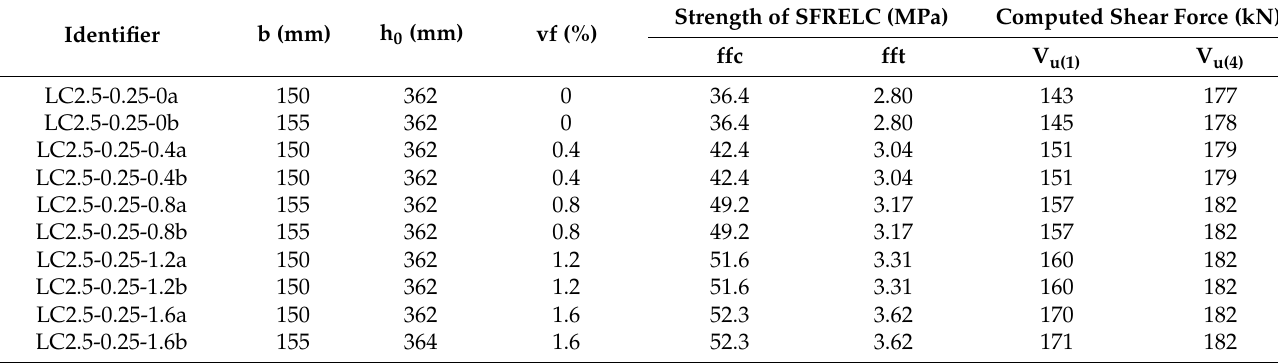
Table 1. Dimension, influencing factor of test beams, and main tested